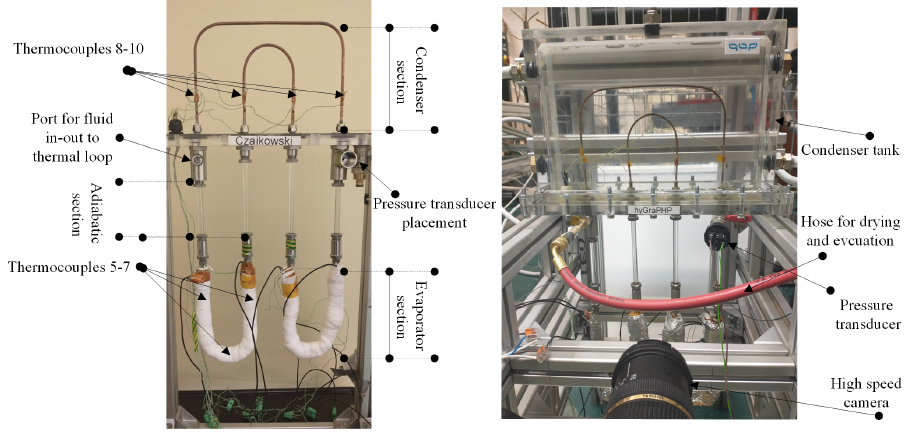
Figure 1. Experimental